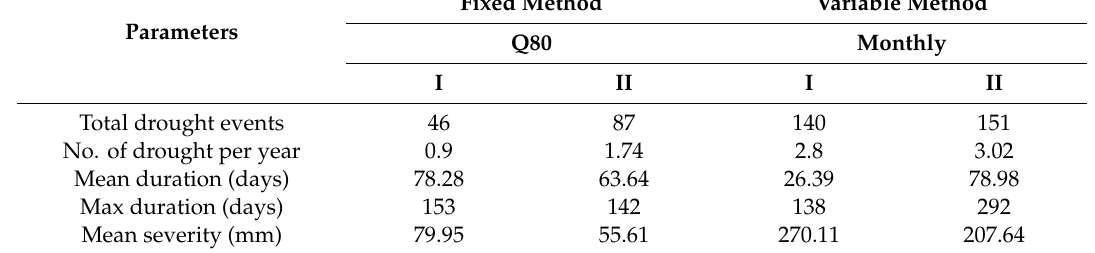
Table 5. Summary of the results based on fixed and transient variable thresholds.